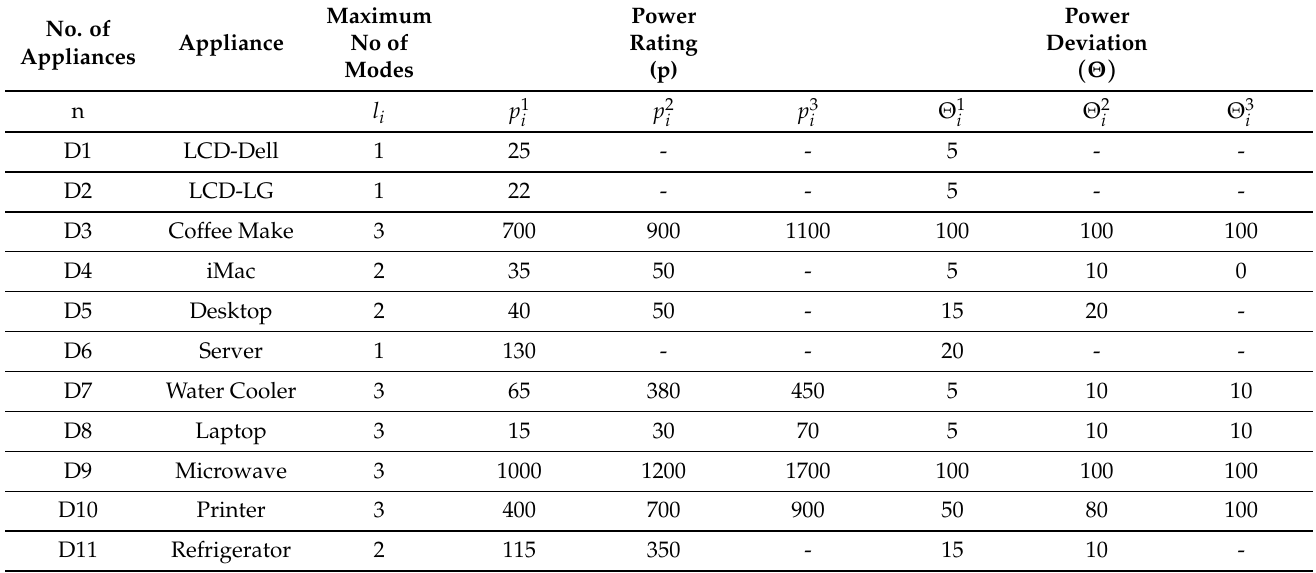
Table 1. Operational modes with corresponding power ratings and power deviation for appliances in the network